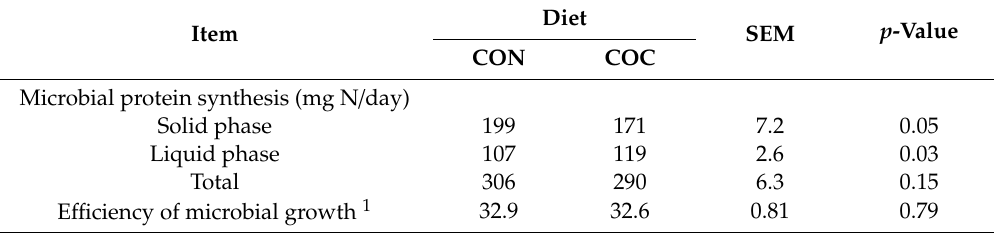
Table 3. E ff ects of partially replacing maize silage and barley straw in a mixed diet (CON) by crude olive cake (COC) on microbial protein synthesis (in solid and liquid digesta) and on its e ffi ciency in Rusitec fermenters ( n = 4).